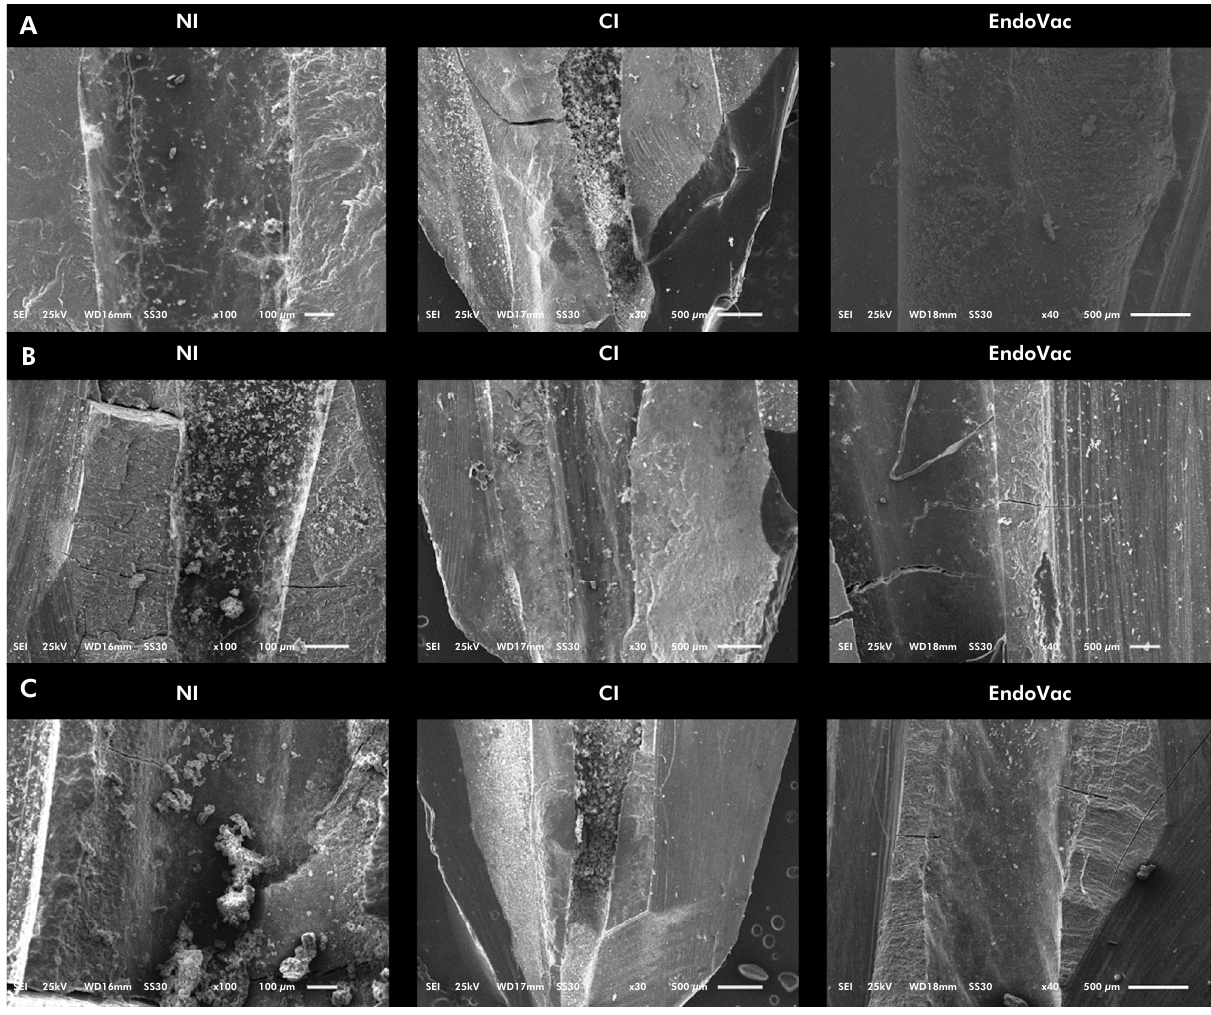
Figure 3. Representative scanning electron microscopy images of the ultrastructural morphological analysis of root canal after biomechanical preparation associated with different final irrigation protocols (no final irrigation, conventional protocol, and EndoVac protocol). (A) Original XP-endo Shaper protocol according to the manufacturer’s instructions, in general, with clean walls for